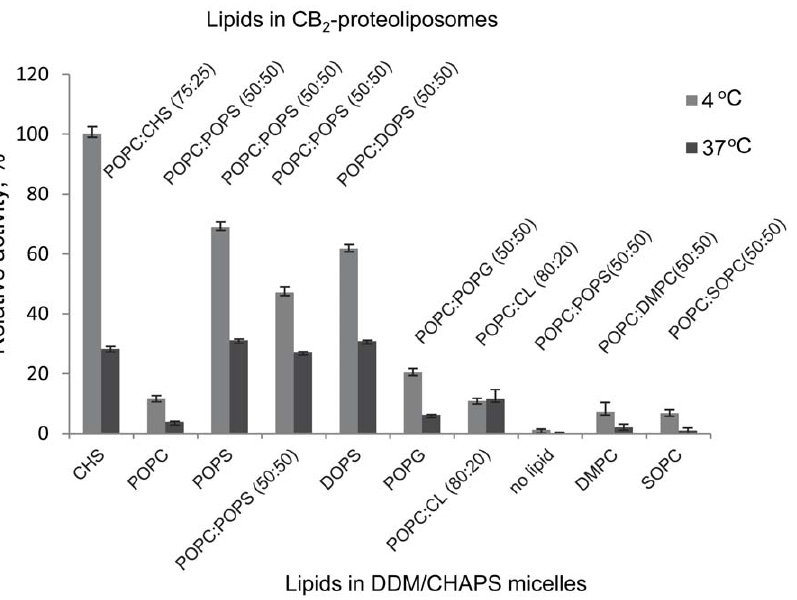
Figure 9. Stabilizing effects of CHS and phospholipids in DDM/CHAPS micelles. Detergent micelles supplemented with lipids as indicated below the graph were incubated either for 2 hours at 4 u C (light-shaded bars) or for 1.5 hours at 4 u C followed by 30 min at 37 u C (dark-shaded bars). The composition of micelles was adjusted as indicated (above the graph) and the protein reconstituted into proteoliposomes on mini-spin detergent absorbent columns (Pierce). The functional activity was measured by the G protein activation assay as described in Materials and Methods. Purified CB 2 reconstituted from CHS/POPC/DDM/CHAPS micelles (final composition of liposomes: CHS/POPC 25:75 mol/mol) was used as an activity standard. Presented are average values of duplicate measurements 6 S.D. (error bars) from representative experiments (n=3).